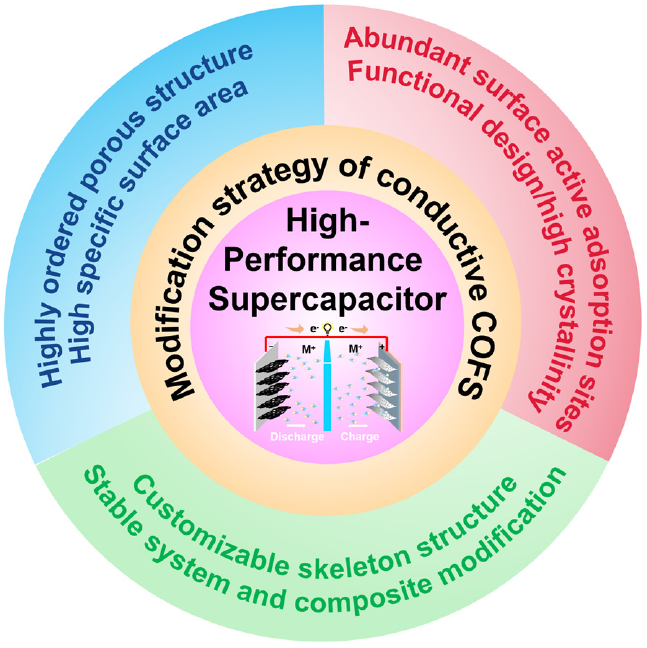
Figure 1. Schematic diagram of modification strategy of conductive COFS in supercapacitors.